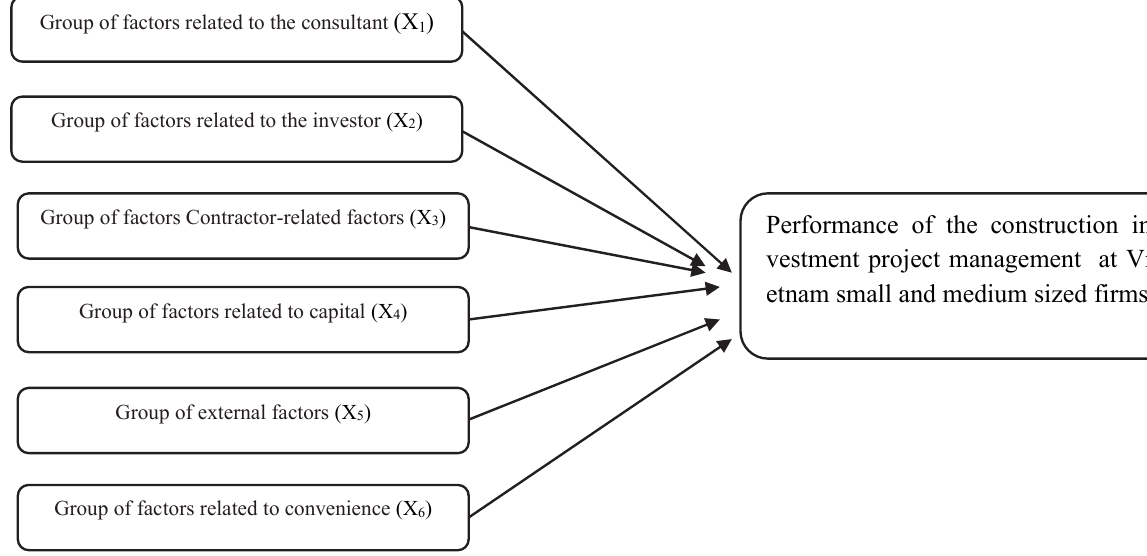
Fig. 1. The study process diagram of